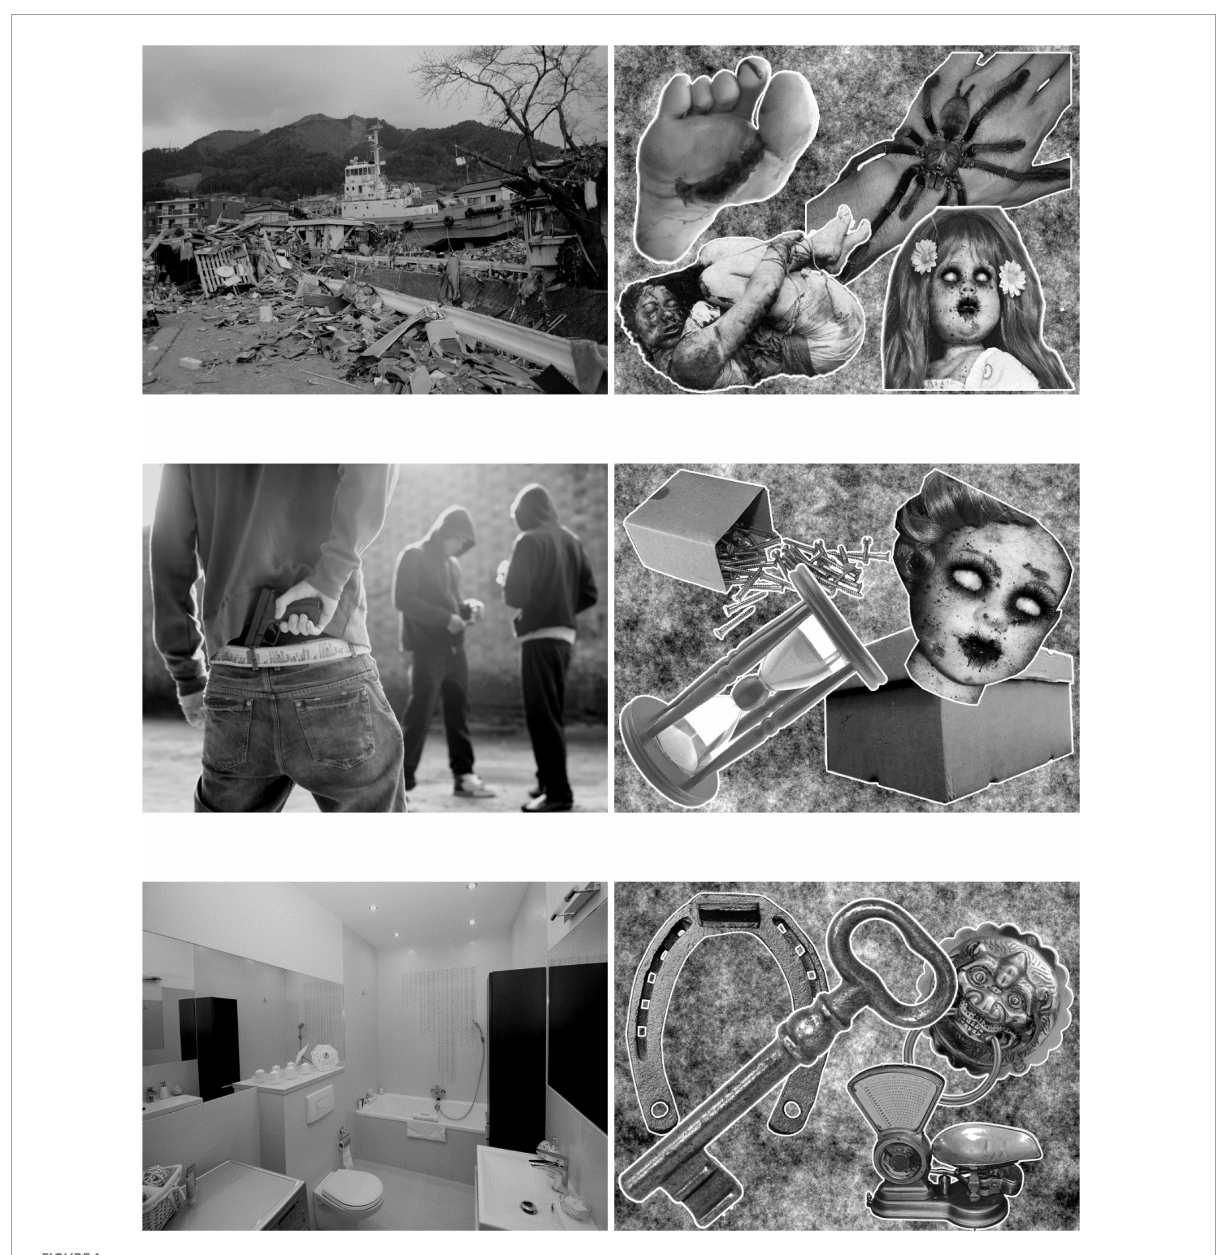
FIGURE1 From left to right and top to bottom, diffuse-high, diffuse-low, focal-high, focal-low, neutral-high, and neutral-low. Each picture was assessed by Study